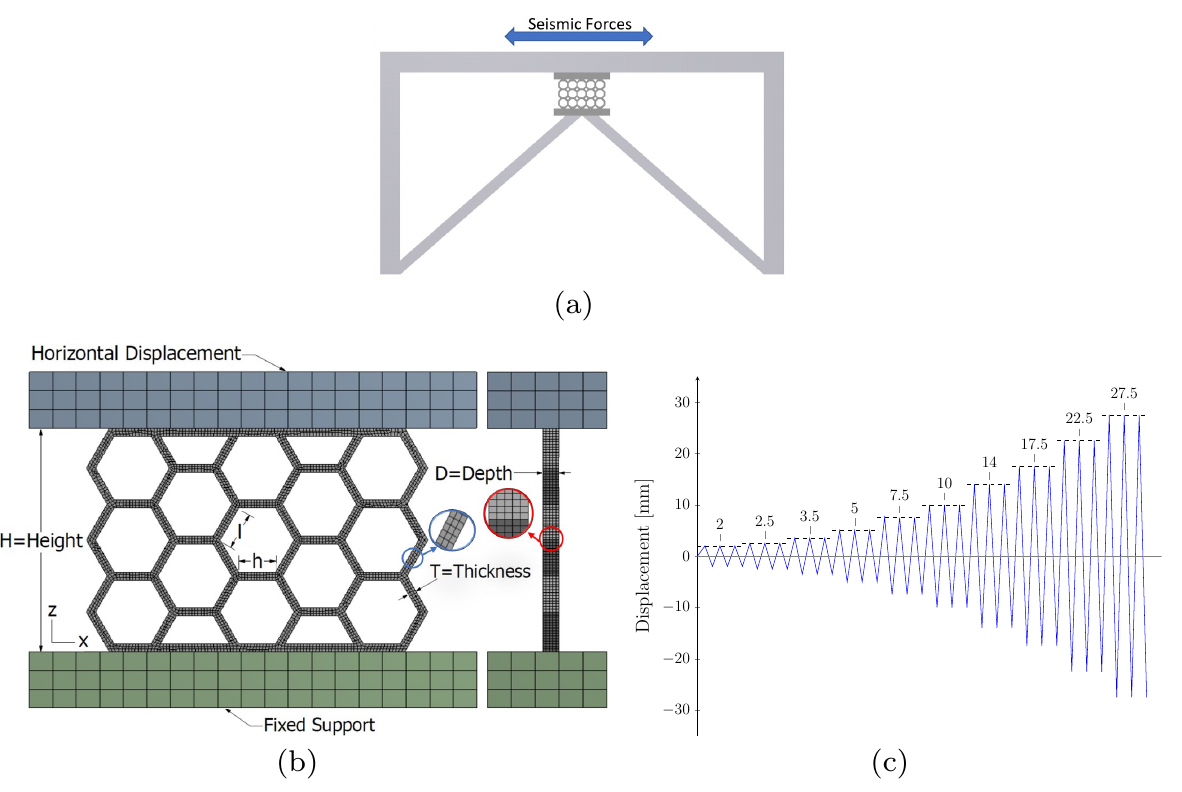
Figure 1. ( a ) SPSYD installation scheme in the structure. ( b ) HHSD with dimension nomenclature, mesh and boundary conditions for the FE model. ( c ) Cyclic loading